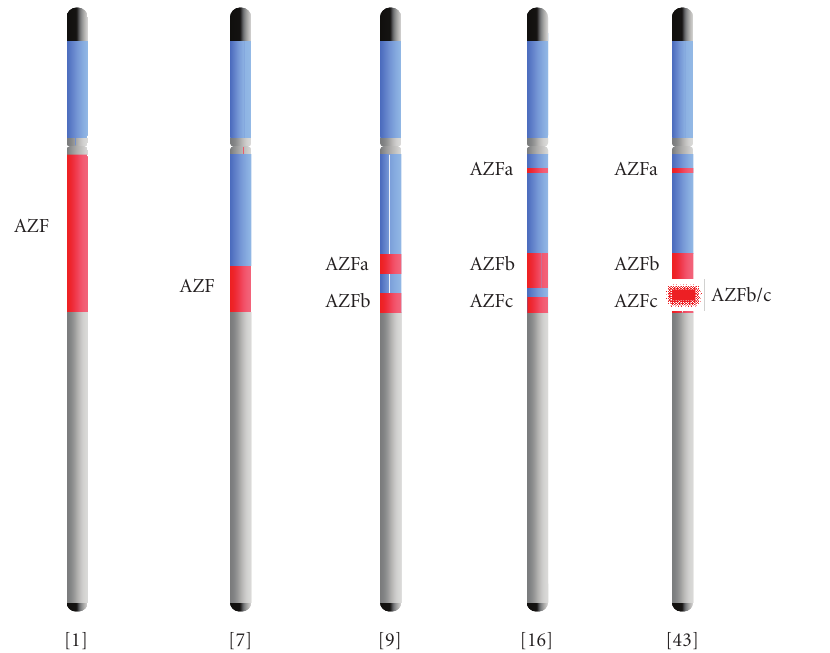
Figure 1: Mapping the azoospermia factor (AZF) region in the human Y chromosome. Heterochromatin is depicted in grey, euchromatin in blue and the two pseudoautosomal regions in black. Starting from the initial identification in 1976 of a genomic domain in Yq euchromatin regulating spermatogenesis, several studies have progressively led to a more refined mapping of this determinant. In 1991 Bardoni and colleagues mapped AZF to the distal end of Yq euchromatin, while in the next year Vogt and colleagues provided evidence for a bipartite organization (AZFa and AZFb). A major landmark was recorded in 1996, with a large-scale deletion mapping project defining three AZF regions (AZFa, AZFb and AZFc) based on the association of specific spermatogenic disruption phenotypes to nonoverlapping deletion intervals. Yet, Repping and colleagues demonstrated in 2002 that the distal end of AZFb corresponded to the proximal domain of AZFc. For complete references please consult the manuscript